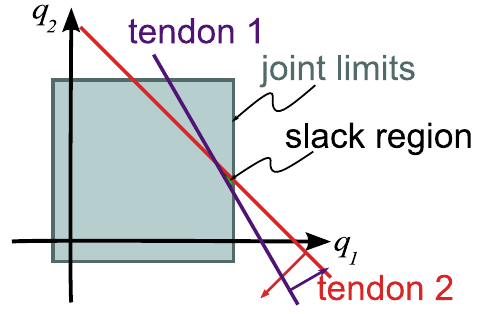
Figure 8. The asymmetric finger trapped near the maximum of q 1 .